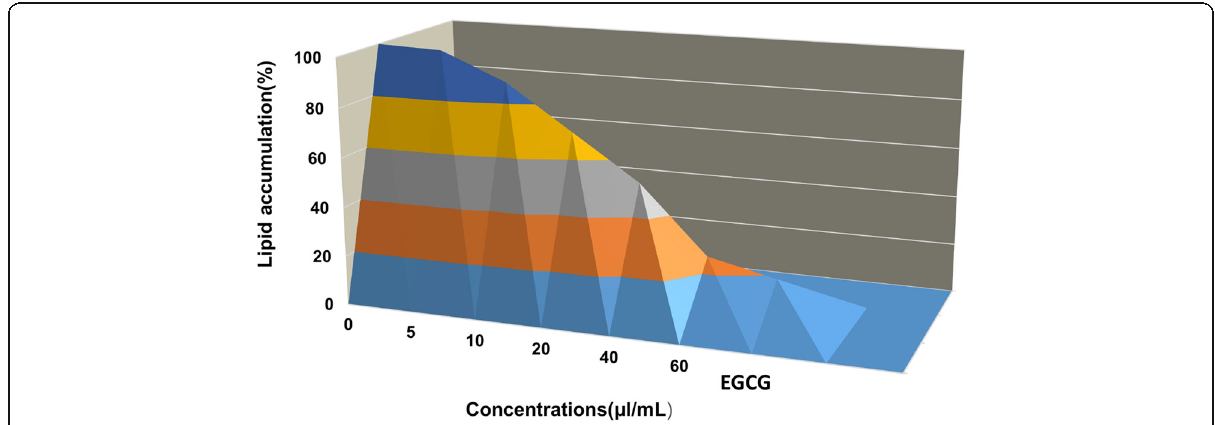
Fig. 7 Inhibition of 3T3-L1 differentiaition and lipid accumulation by various concentrations of crude microcystins (control without microcystins) from the lowest concentration 5 μ l/mL to the highest concentration respectively 60 μ l/mL). Data are expressed as means of values ± SEM. Data are statistically significant at P <